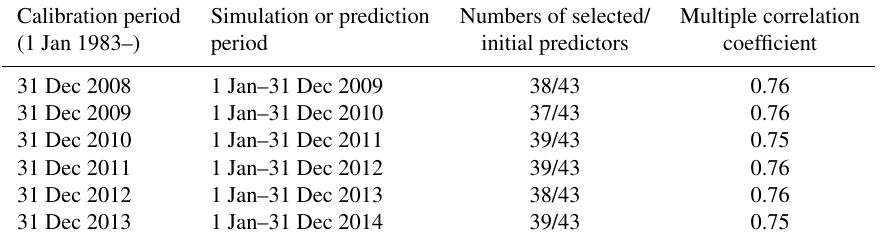
Table 6. Statistical parameters of stepwise-regression equations used for prediction during different calibration periods in northern China.